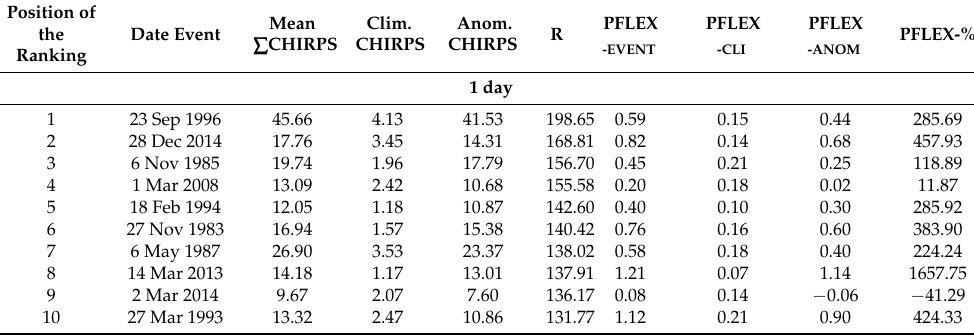
Table 2. List of the top 10 extreme precipitation events out of a total of 100 cases with different durations ranked for the Danube River Basin. The columns for each event show: The position of the ranking, the date of the event, the daily mean precipitation value (Mean ∑ CHIRPS), daily climatological precipitation value (Clim. CHIRPS), daily precipitation Anomaly (Anom. CHIRPS), value of ranking index (R), mean E − P < 0 values from the Mediterranean Sea into the Danube River Basin for day/days of the extreme precipitation event (PFLEX- EVENT ), daily climatological E − P < 0 value (PFLEX- CLI ), daily anomaly of E − P < 0 values (PFLEX- ANOM ), and percentage of Mediterranean contribution for each event calculated by FLEXPART (PFLEX-%). Units of calculations with CHIRPS and PFLEX are in mm/day; R has no units; and the last column is expressed in %. CHRIPS, Climate Hazards Group Infra-Red Precipitation with Station dataset; PFLEX, available moisture from the Mediterranean Sea (E − P < 0 values) obtained via Lagrangian